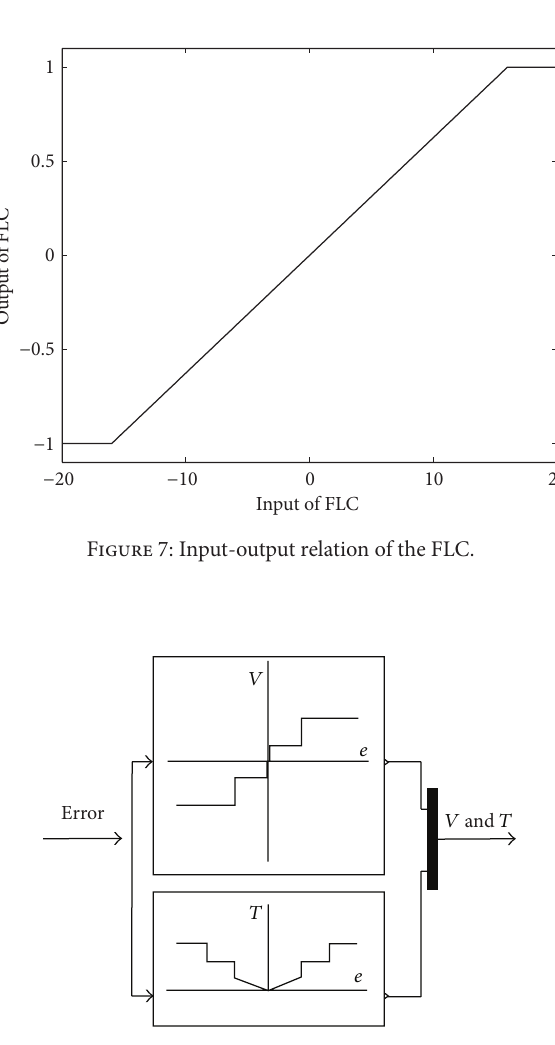
Figure 8: Typical functions for 𝑉 and 𝑇